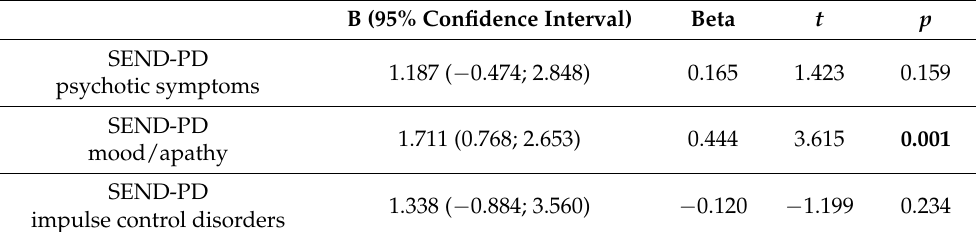
Table 5. Multiple linear regression analysis of factors contributing to caregiver burden (PDCB, n = 82); R = 0.630; R 2 = 0.397; adjusted R 2 = 0.373. B (95% Confidence Interval) Beta